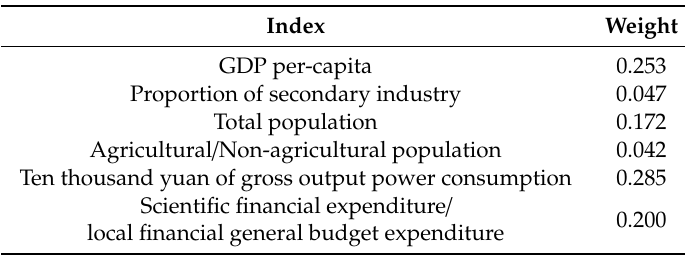
Table 3. Evaluation indexes weight.